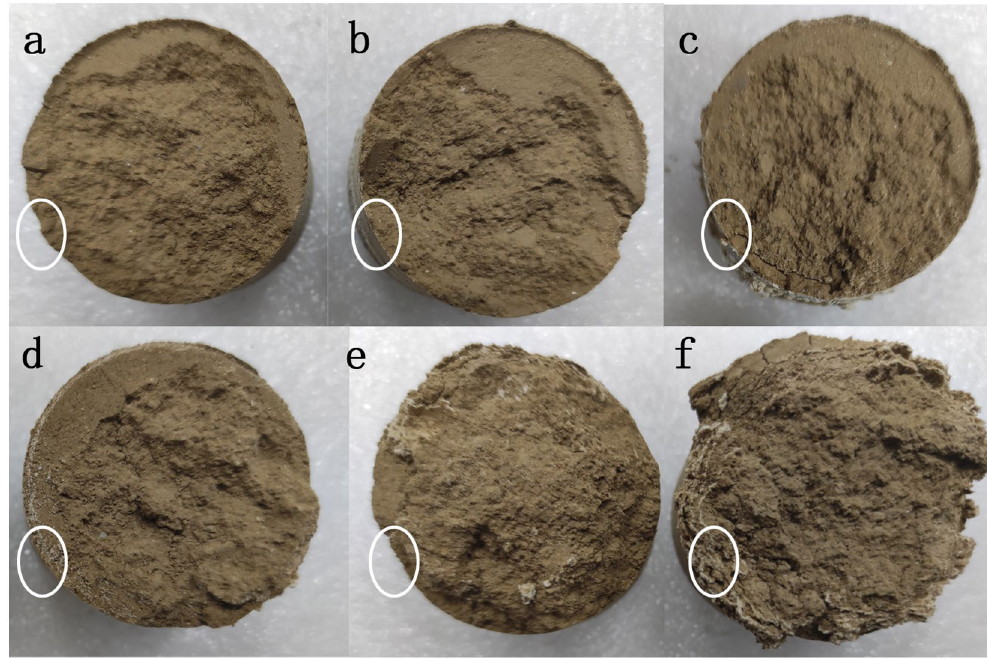
Figure 4. Salt crystallization in soil column with different cycles of 3% MgSO 4 solution: ( a ) 2nd cycle; ( b ) 4th cycle; ( c ) 7th cycle; ( d ) 10th cycle; ( e ) 15th cycle; ( f ) 20th